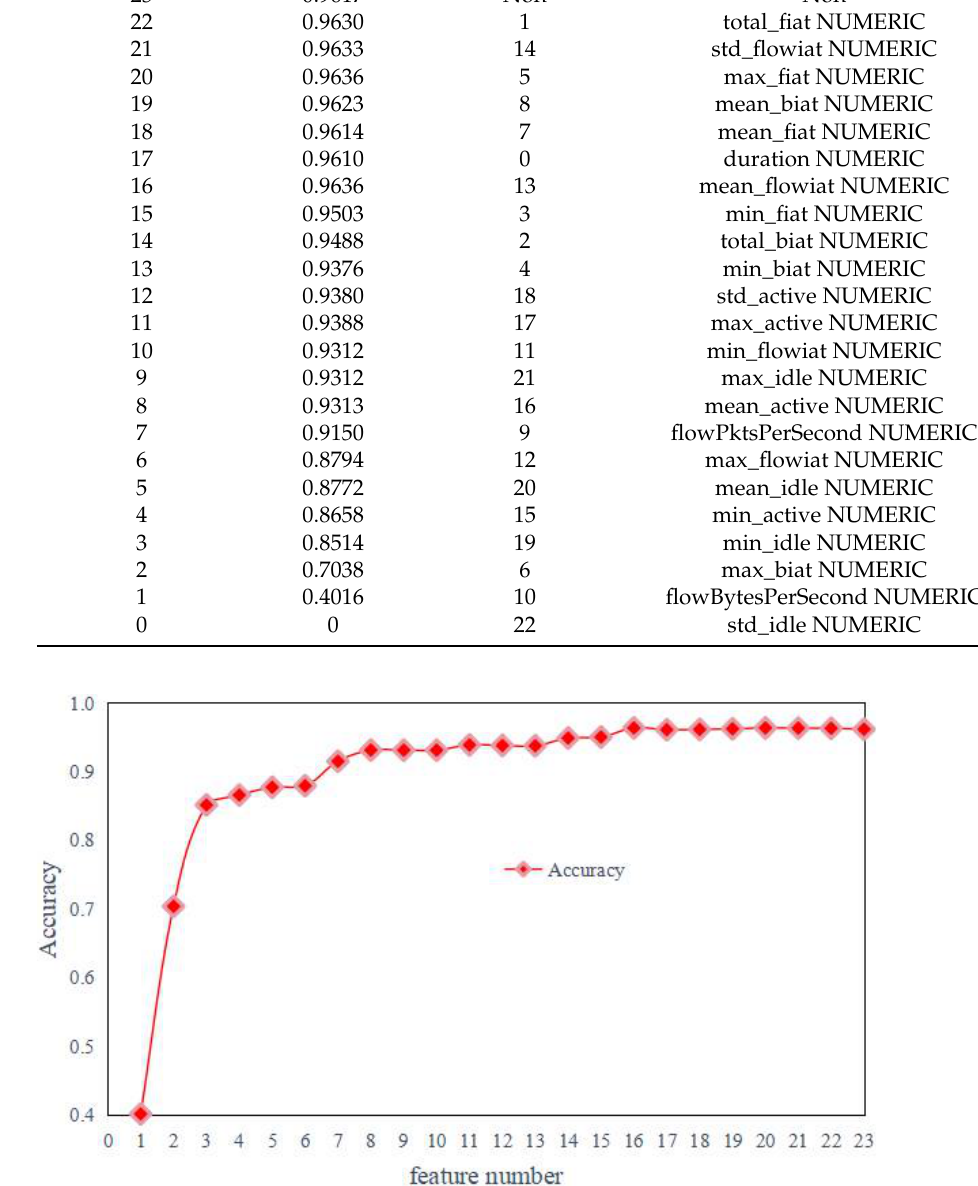
Figure 9. Importance of data features.